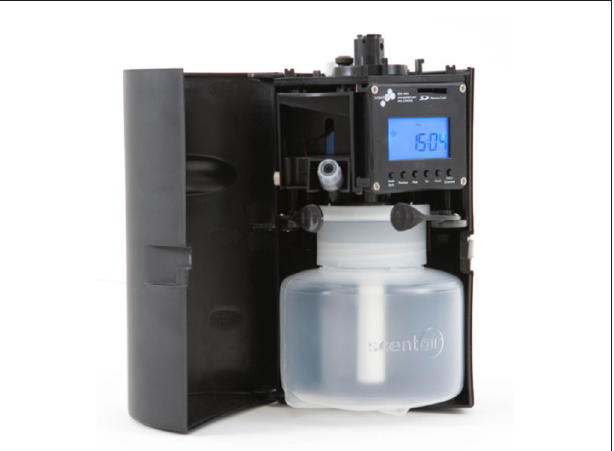
FIGURE 2 | ScentDirect odor diffusion system.